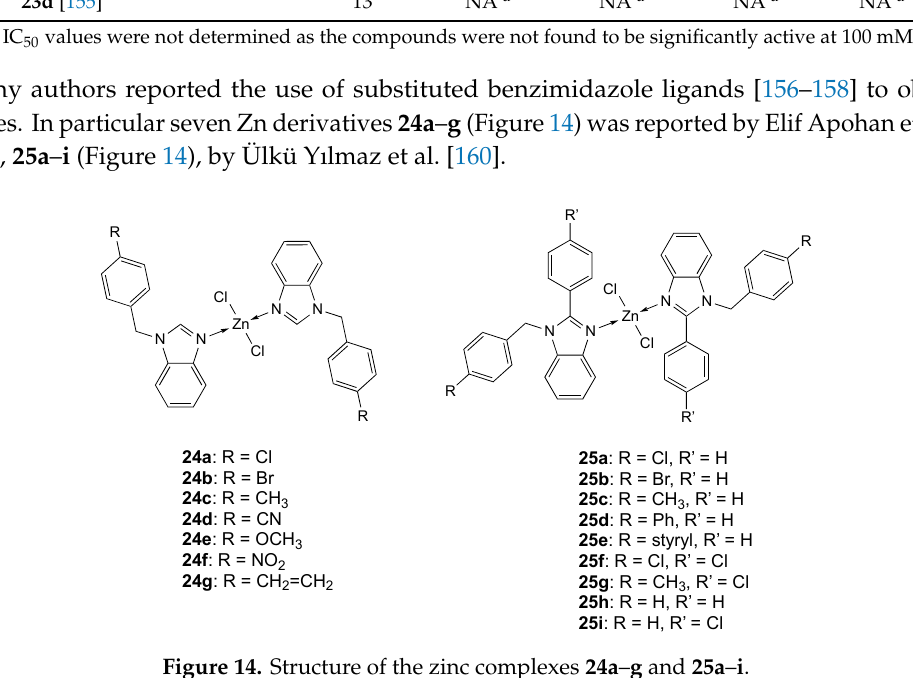
Figure 14. Structure of the zinc complexes 24a – g and 25a – i .